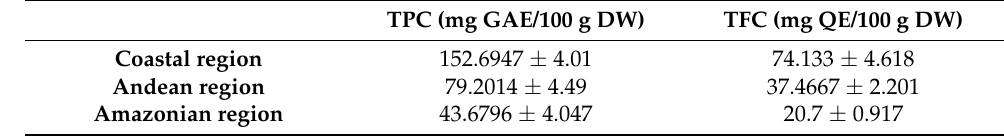
Table 4. Total phenolic and flavonoid contents in Moringa leaves from three Ecuadorian regions.